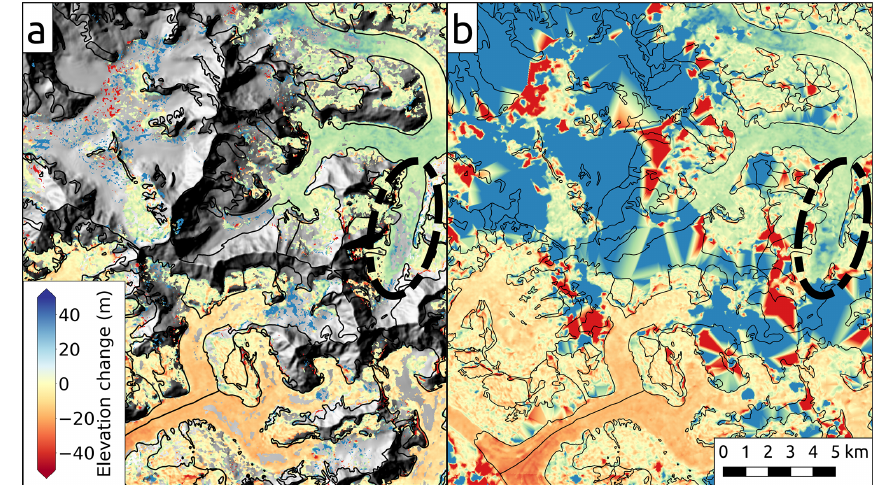
Figure 13. Elevation changes over the upper portion of Johns Hopkins Glacier, estimated by differencing an ASTER DEM acquired on 13 August 2015 and the SRTM (a) with correlation-masked values left as no data; (b) with voids filled using linear interpolation. Clear interpolation-related artifacts are seen in the sparsely sampled accumulation area. Ellipses highlight an area over the glacier where linear interpolation performs well, with no obvious artifacts in the interpolated